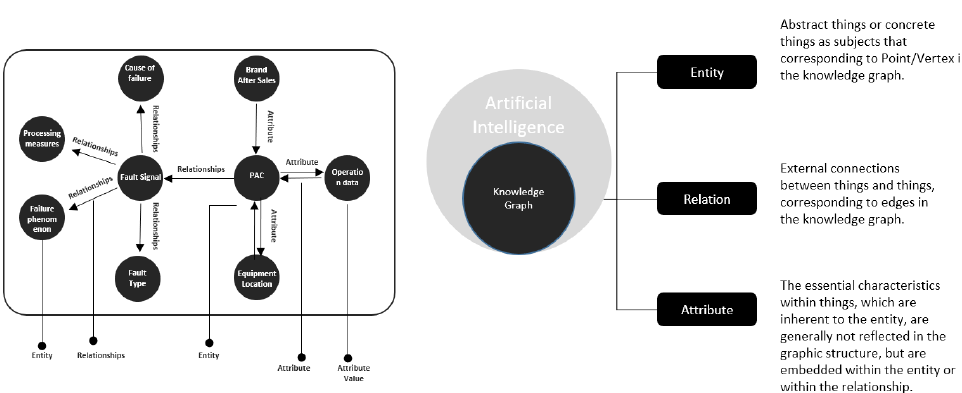
Figure 1. Knowledge Graph Definition at a